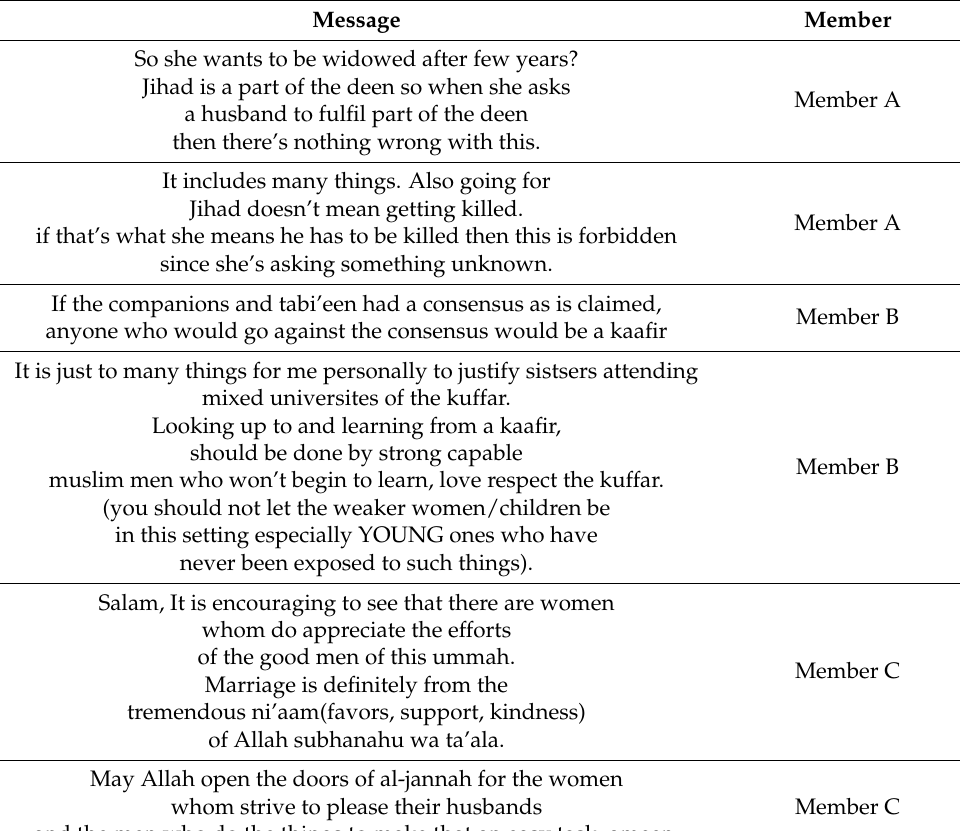
Table 1. Sample of posts by some active members of the Islamic Network forum anonymized with the name “Member